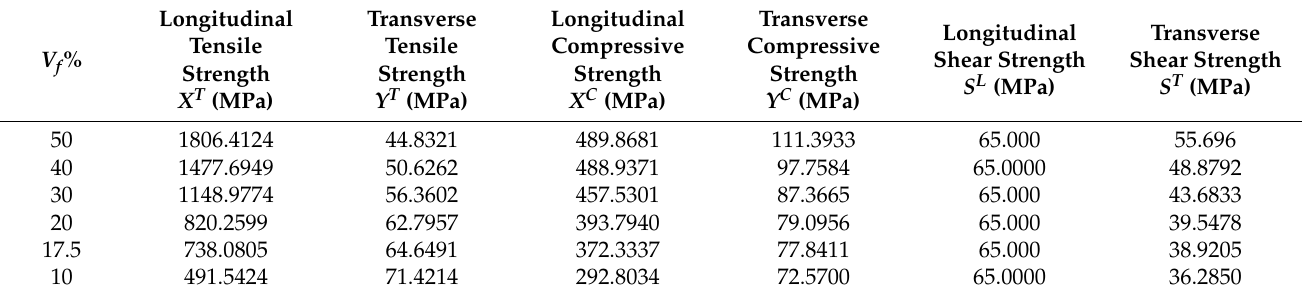
Table 5. Hashin’s damage model strength data for various V f % values.